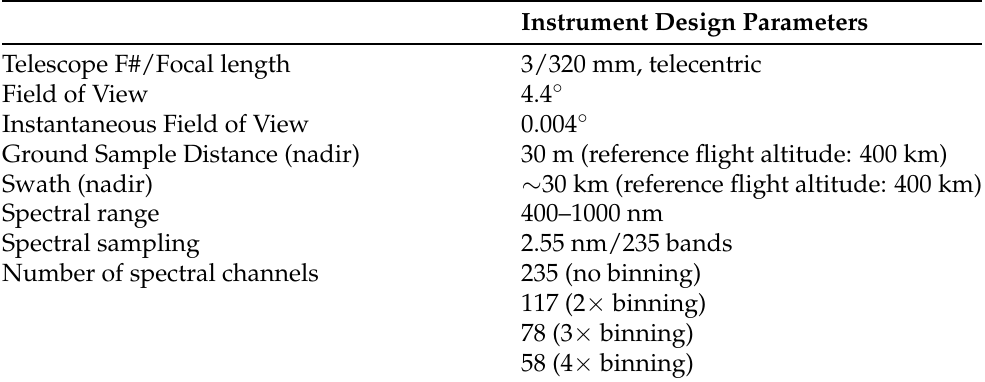
Table 1. DESIS design specifications, from Müller et al. [18],